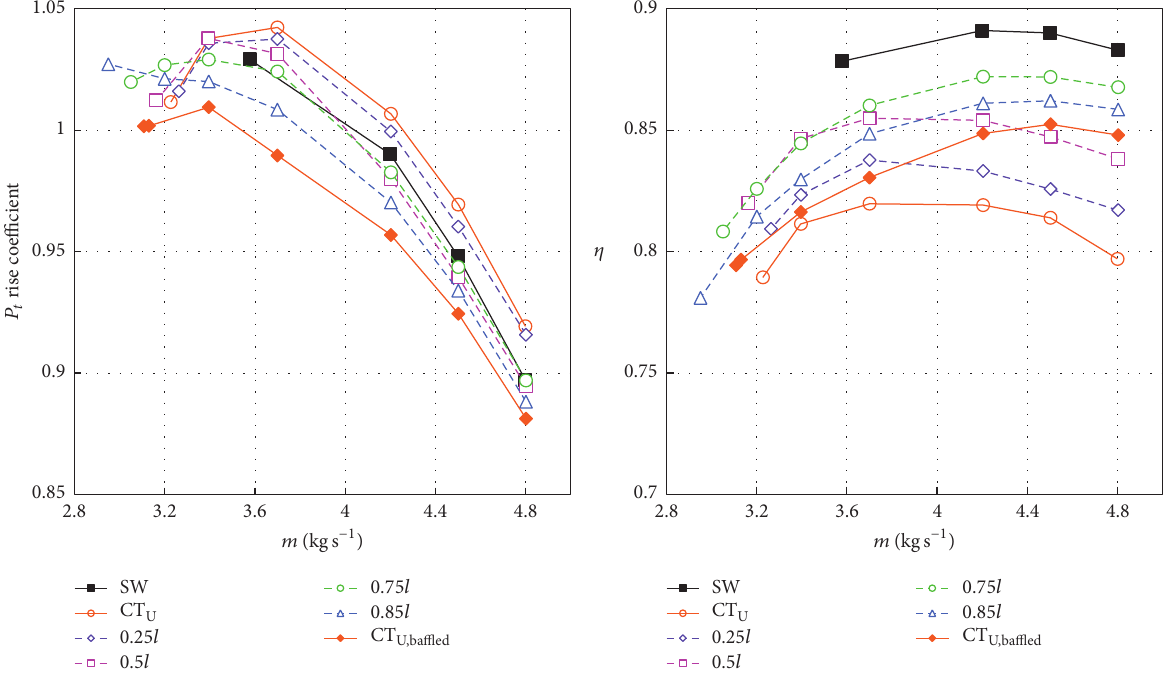
Figure 14: Total performance of different baffle length.